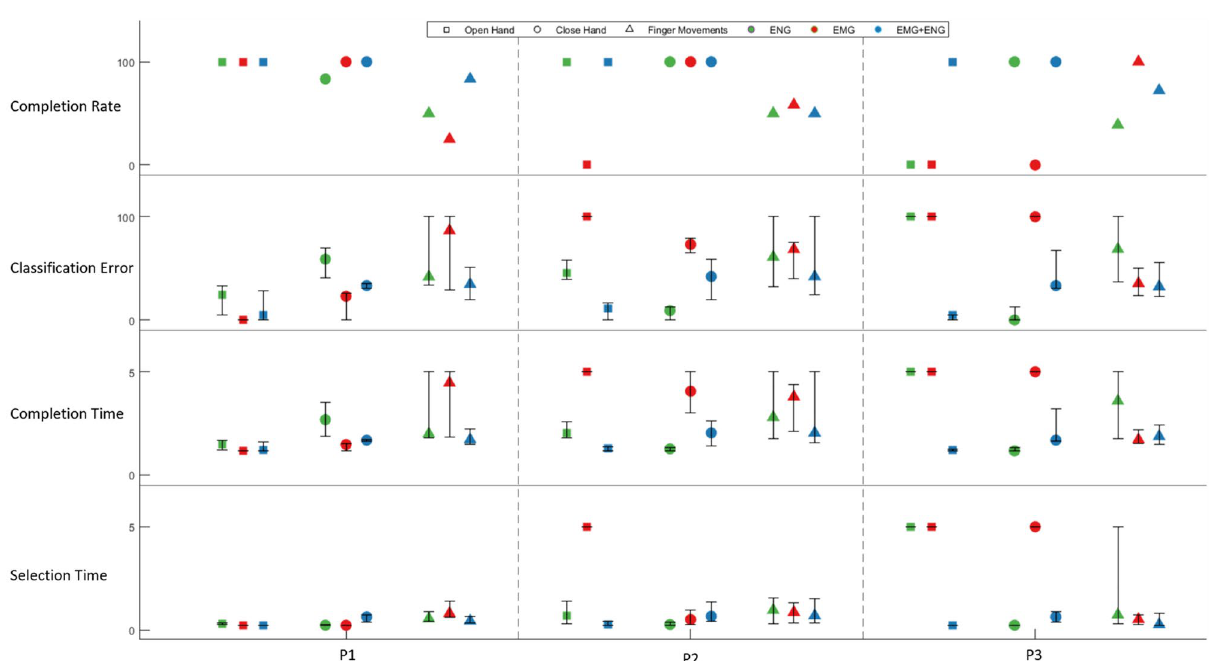
Figure 3. Online pattern recognition results from the Motion Test performed by the three participants (P1–3) over three different scenarios: (1) ENG alone (green), (2) EMG alone (red), and (3) the combination of EMG and ENG (blue). The outcomes are completion rate, median of classification error, median of reported completion time, and median of selection time. Finger movements include ring flex, little flex, for P1, ring to thumb, little to thumb for P2 and thumb flex, index flex, and middle flex for